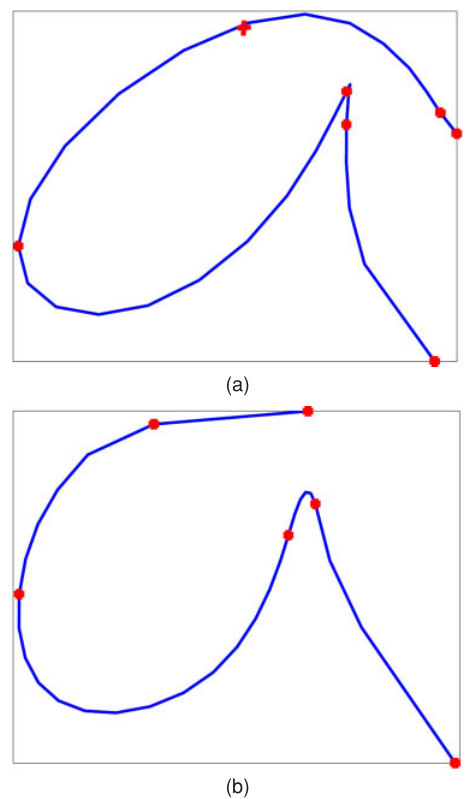
Figure 4 Two similar movements of the handwriting of the letter “a” (solid line), and their extracted features (circle